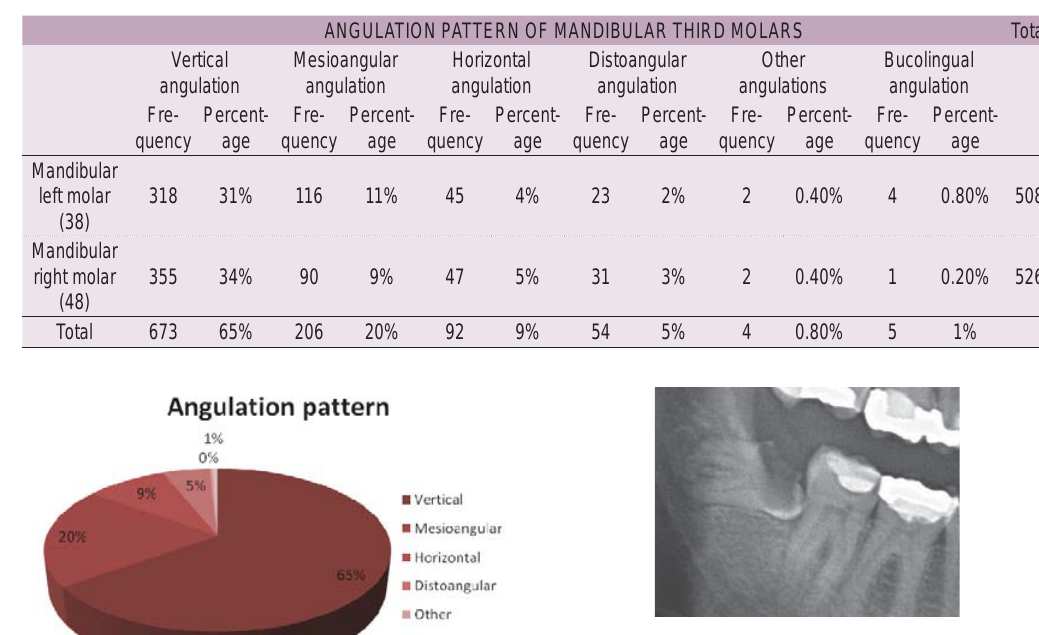
FIGURE 2. Pathology associated with impacted mandibular third molars: radiograph of dental caries in semi-impacted mandibular third molar.